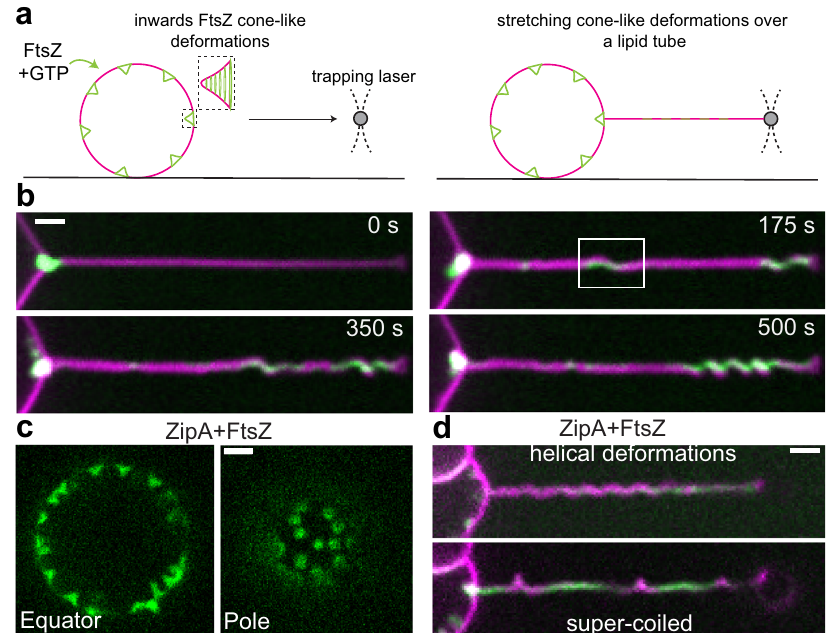
Fig. 2 Inwards FtsZ-induced conical deformations are geometrically equivalent to spring-like deformations on a tubular surface. a To characterize the protein structures forming the cone-like deformations, we stretched the deformed vesicle membrane into a tubular geometry. Large and soft lipid tubes were pulled from weakly surface-attached GUVs by moving the GUVs relative to an optically trapped bead. b A representative time acquisition shows that FtsZ-YFP-mts entered the tube promoting coiling as a function of time ( N = 12). Clustering of protein toward the tip correlates with a spring-like shape. Green and magenta corresponds to fl uorescence signal of FtsZ-YFP-mts and lipid, respectively. c To rule out that arti fi cial attachment of the FtsZ-YFP-mts is responsible of the helical transformation, we reconstituted wild-type FtsZ anchored to the membrane via ZipA. When wild-type FtsZ was added to ZipA- decorated vesicles, rings were self-assembled causing inwards cone-like deformations ( N = 74) such as in the case of FtsZ-YFP-mts. d After pulling lipid tubes, similar helical deformations and supercoiled regions were observed con fi rming that torsion is related to the FtsZ core of the polymer ( N = 3 out of 18 pulled tubes). Fluorescence signal of wt-FtsZ-Alexa 488 is shown in green while siZipA remains unlabeled and lipids are shown in magenta. (Scale bar = 2 µ